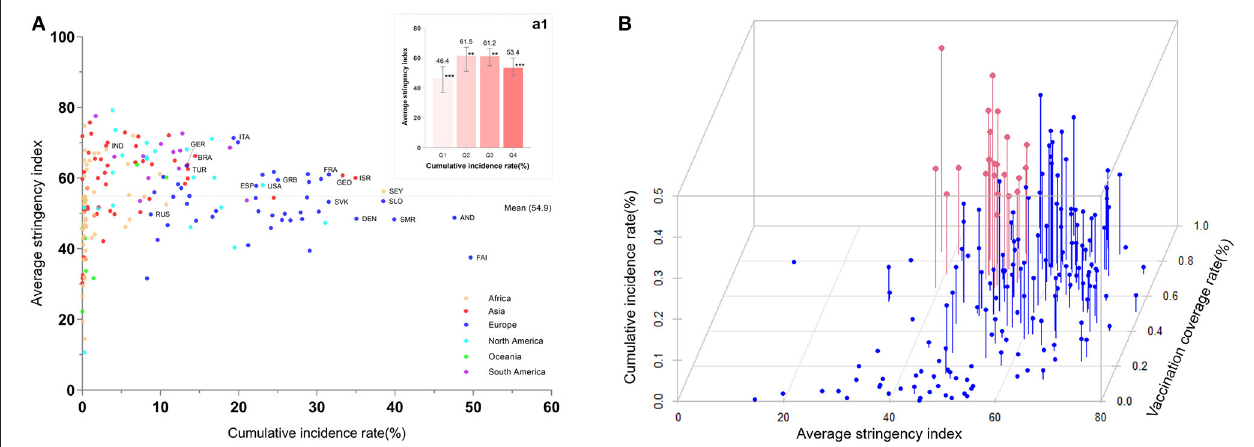
FIGURE 6 | Distribution of the position between cumulative incidence rate, vaccination coverage rate, and average stringency index among countries. In part (A) the number denotes median and error bars denote quantiles 0.025 and 0.975. *** means the group has significant differences from the other three groups, and ** means the group has a significant difference from the other two groups. (A) shows that countries with high and low incidence rates both had a lower GSI, whereas countries with a medium incidence rate (Q2 and Q3 groups) had the highest GSI. Dots with red color in the (B) represent the countries with higher VCR but still a high incidence due to a lack of appropriate